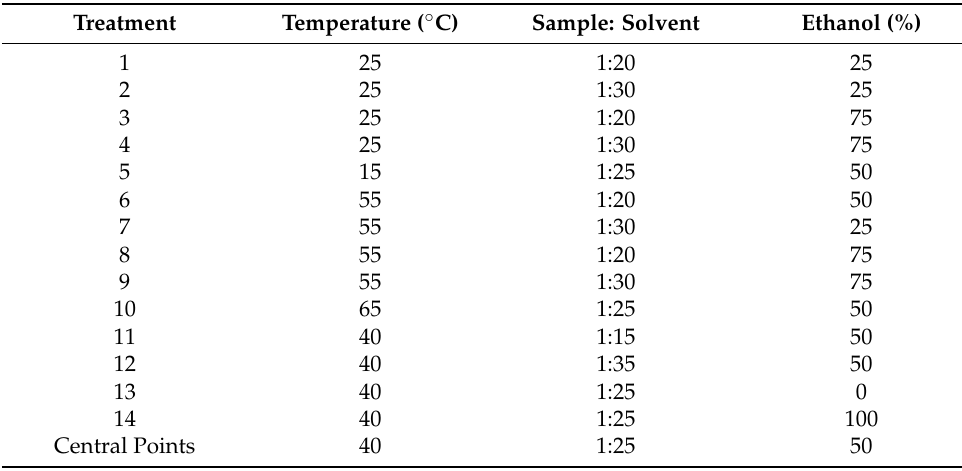
Table 2. Fully coded three-variable central composite design